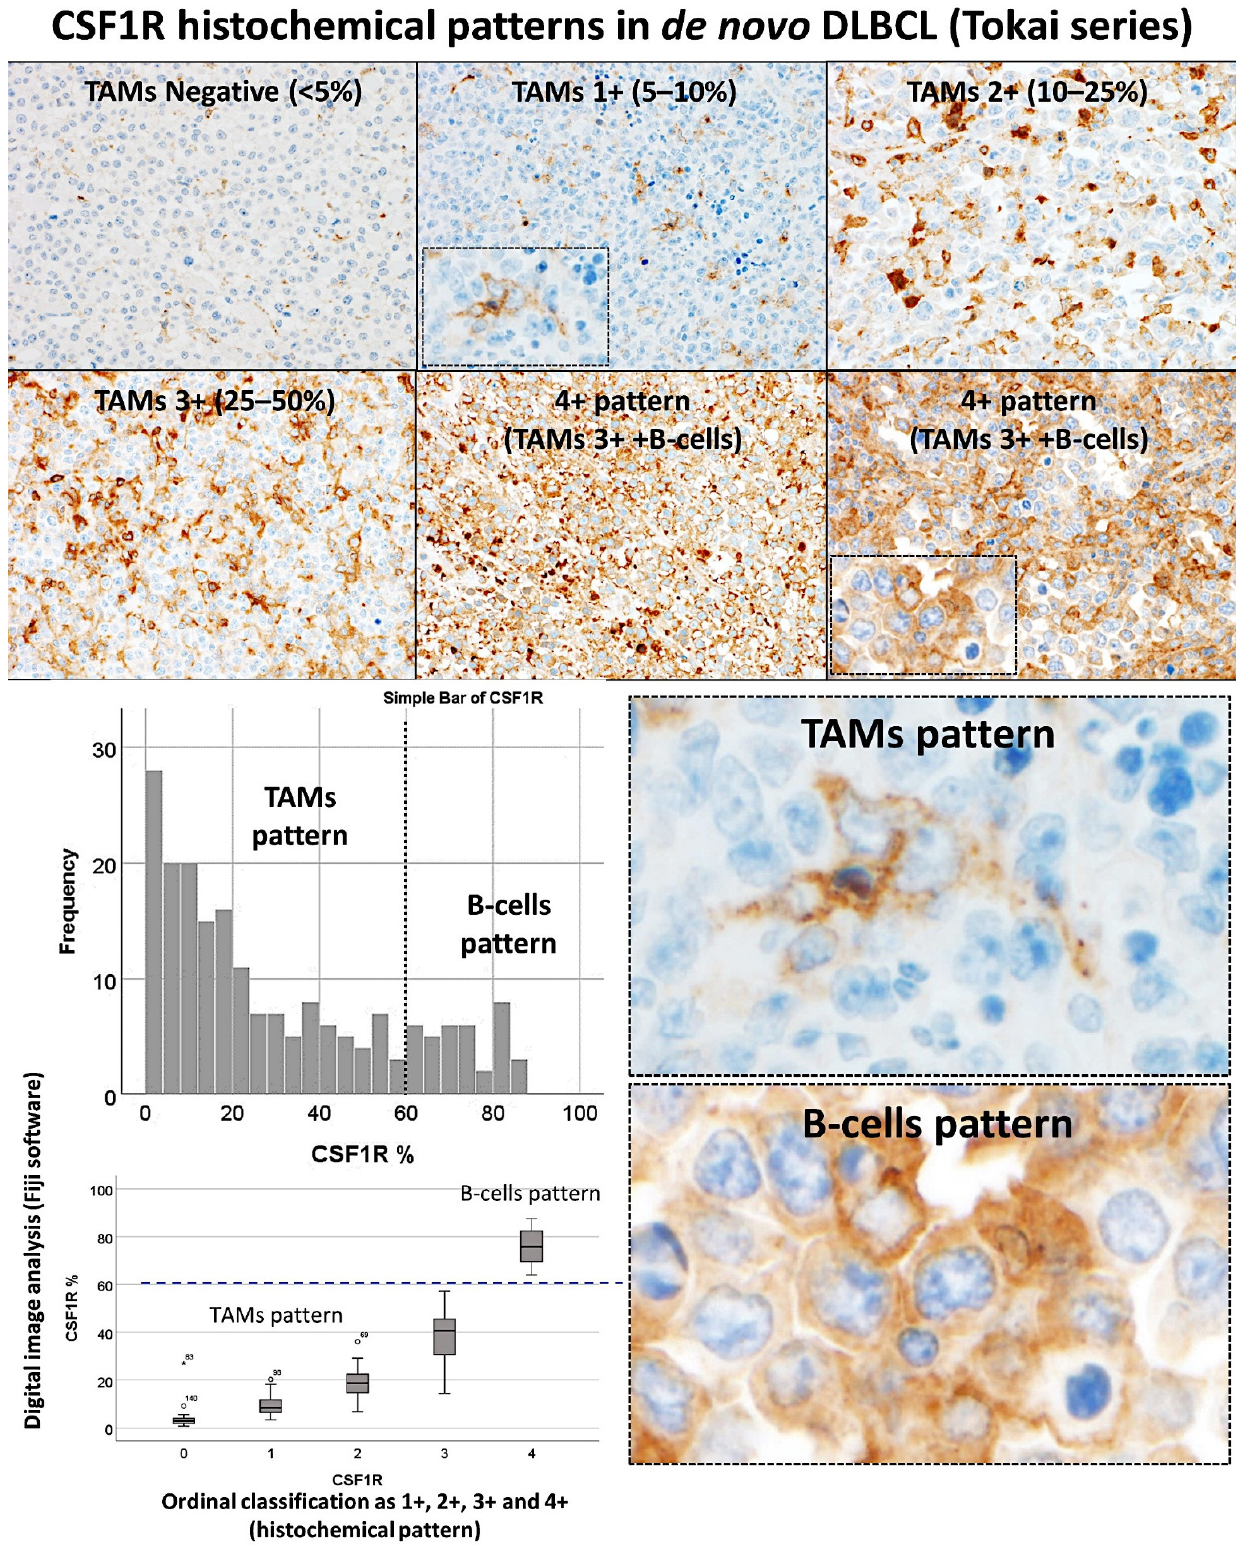
Figure 2. Quantification of Macrophage colony-stimulating factor 1 receptor (CSF1R) in the samples of Tokai University. In diffuse large B-cell lymphoma (DLBCL), the CSF1R expression was characteristic of tumor-associated macrophages (TAMs). In addition, a CSF1R-positive B-cells pattern was also found.